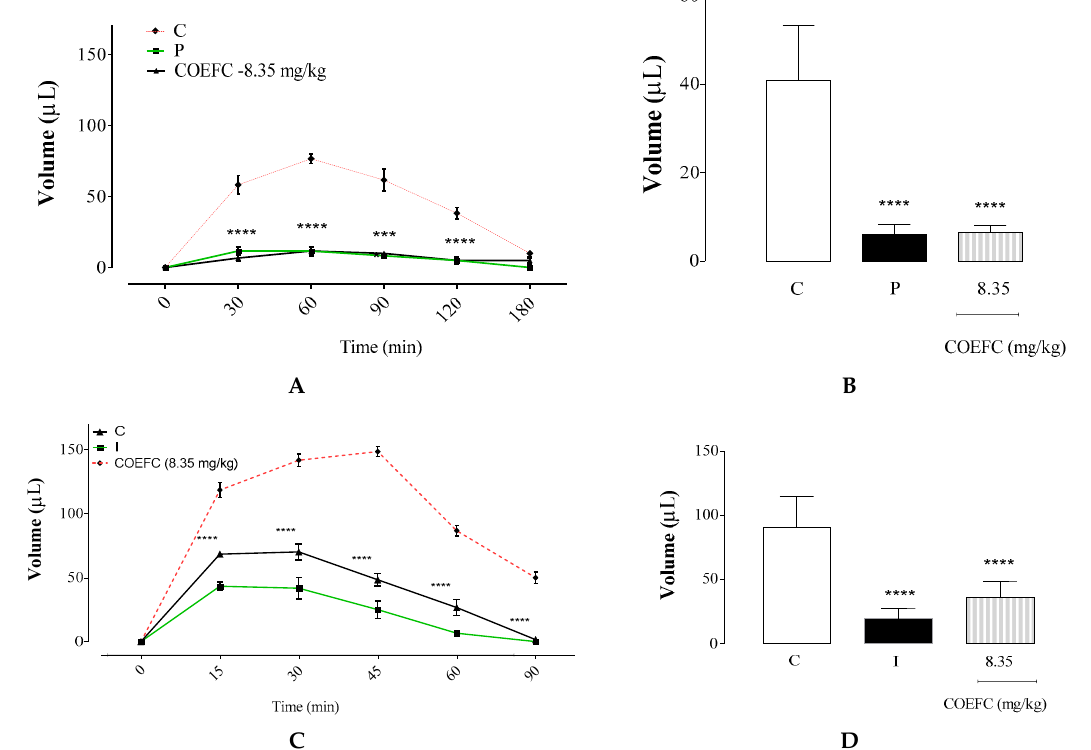
Figure 5. E ff ect of the COEFC (8.35 mg / kg / p.o.) on paw edema ( A , B ) intraplantar injection of 1% Figure 5. Effect of the COEFC (8.35 mg/kg/p.o.) on paw edema ( A,B ) intraplantar injection of histamine and ( C , D ) induced by the 1% arachidonic acid in mice. ( A ) Edema value induced by 1% histamine and ( C,D ) induced by the 1% arachidonic acid in mice. ( A ) Edema value induced by histamine ( µ L) up to 180 min between control (C) (saline / tween—0.1 mL / 10 g / p.o.), promethazine (P) (6 histamine ( μ L) up to 180 min between control (C) (saline/tween—0.1 mL/10 g/p.o.), promethazine (P) mg / kg / p.o.), ( B ) Results of median paw volume ( µ L) the 3rd hour after the moment of application, ( C ) (6 mg/kg/p.o.), ( B ) Results of median paw volume ( μ L) the 3rd hour after the moment of application, Edema value induced by arachidonic acid ( µ L) up to 90 min between the control (C) (saline / tween—0.1 ( C ) Edema value induced by arachidonic acid ( μ L) up to 90 min between the control (C) mL / 10 g / p.o.), indomethacin (I) (10 mg / kg / s.c.) and COEFC (8.35 mg / kg / p.o.) groups. ( D ) Results of median paw volume ( µ L) 90 min after the moment of application. Values represent the mean ± S.P.M. ( n = 6 / group). **** p < 0.0001 vs. control; Statistical analysis: ANOVA followed by the Dunnett’s test with multiple